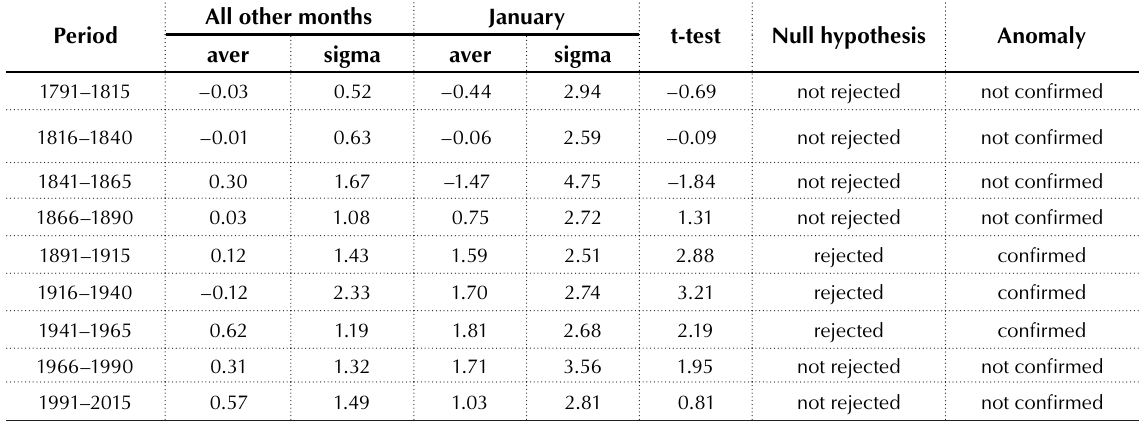
Table B 2. T-test of the January Effect for the US stock market during 1791–2015